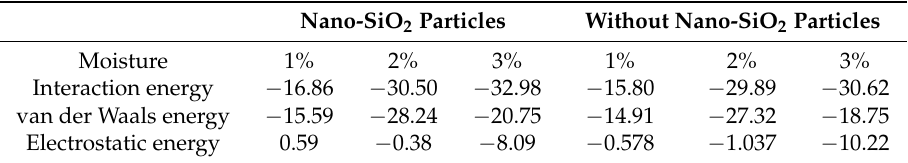
Table 3. The interaction energy of water molecules and oil media